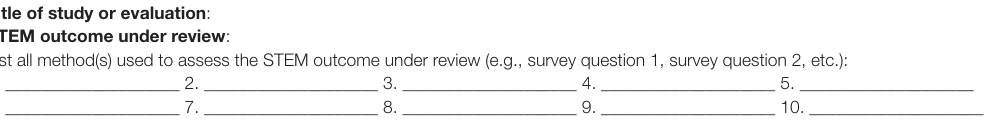
TABLE 5 | STEM impact rubric for qualitative studies. Title of study or evaluation : STEM outcome under review